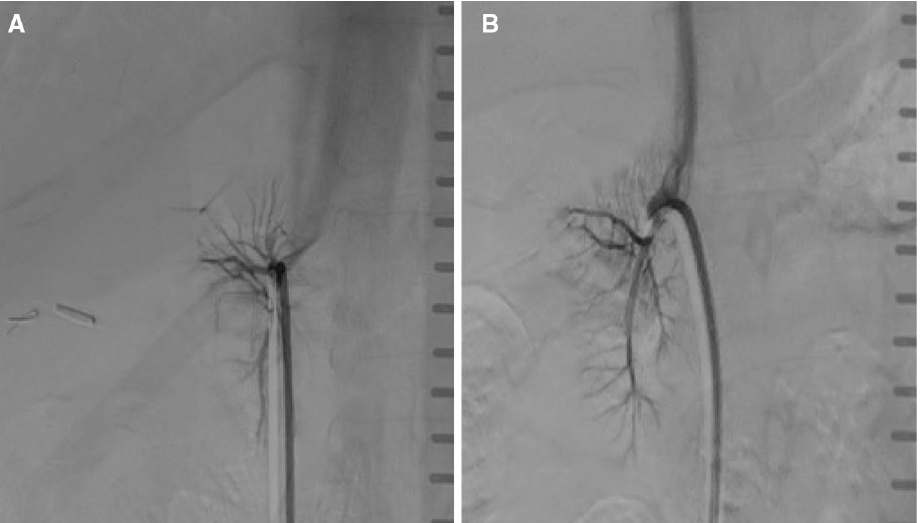
Figure 2. DSA of selectively catheterized right adrenal veins during AVS using Allura Xper ( A ) and AlluraClarity ( B ). A: 54y female, BMI 27.4 kg/m 2 using Allura Xper with a cumulative dose area product of 205.2 Gycm 2 . B: 56y female, BMI 26.2 kg/m 2 using AlluraClarity with a cumulative dose area product during of 169.7 Gycm 2 . Both observers rated the image quality for Allura Xper and for AlluraClarity as 4 = excellent including a sharp delineation of the adrenal veins with sufficient contrast, contrast stain of the adrenal gland and low level of subjective image noise.